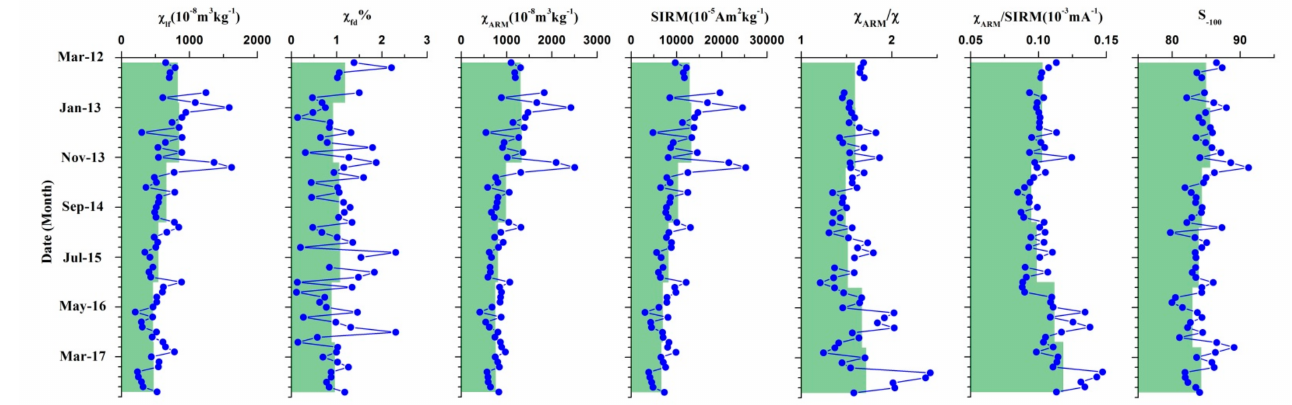
Figure 4. Monthly variations of magnetic parameters of atmospheric dustfall. The green part indicates the annual average concentration variation of each